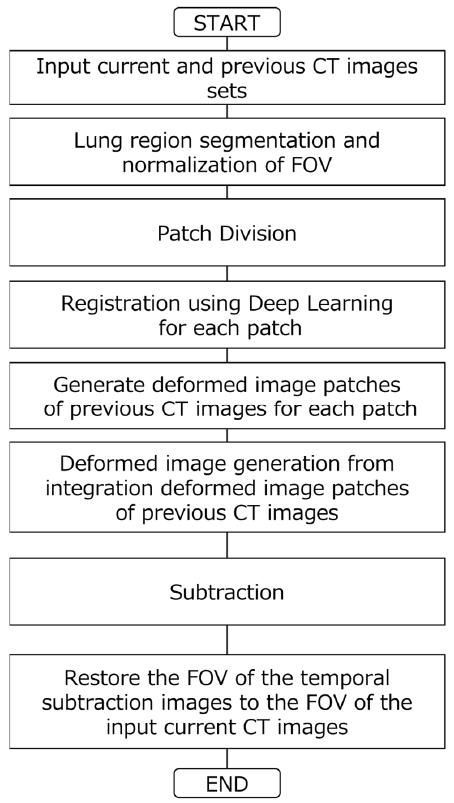
Figure 1. Overview of proposed CT temporal subtraction method.